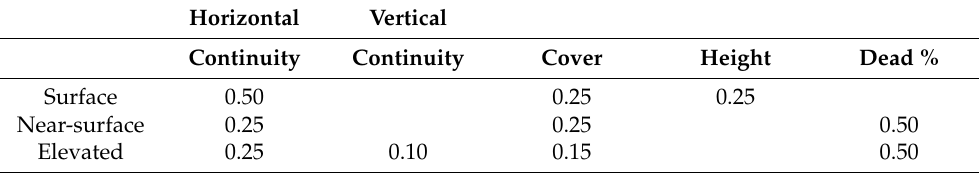
Table 3. Weightings used to estimate the level of fuel hazard